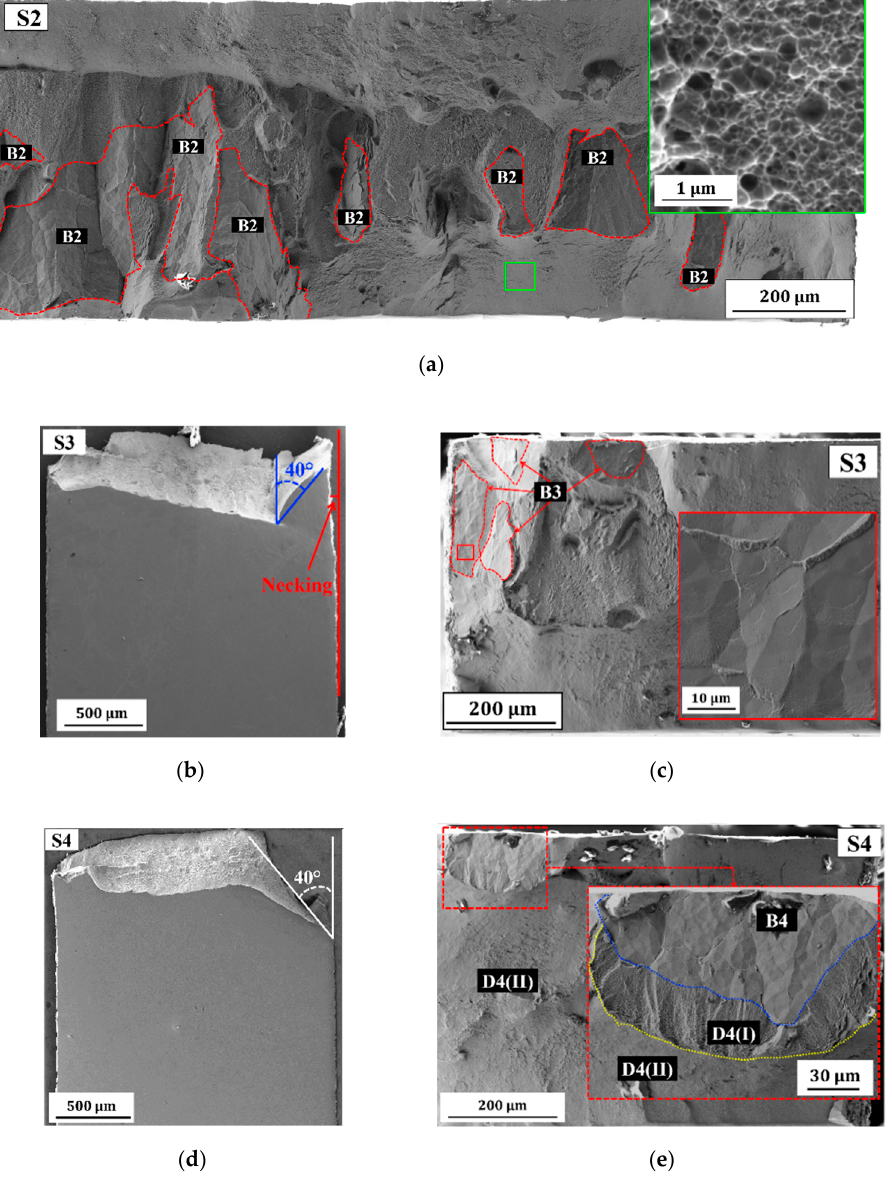
Figure 5. ( a ) A SE electron image of the fracture surface of sample 2 (S2) showing brittle (B2) and ductile (rest) fracture regions (inset shows a detailed image of the ductile fracture surface taken at the area marked with the green box). ( b , d ) SE images of surface morphology at gauge section after tensile test of ( b ) sample 3 (S3) and ( d ) sample 4 (S4); ( c ) a SE image of the fracture surface of S3 showing the brittle (B3) and ductile (rest) fracture regions (inset show a detailed image of the brittle region marked with the red box); ( e ) a SE image of the fracture surface of S4 showing brittle (B4) and ductile (D4(I) and D4(II)) fracture regions.